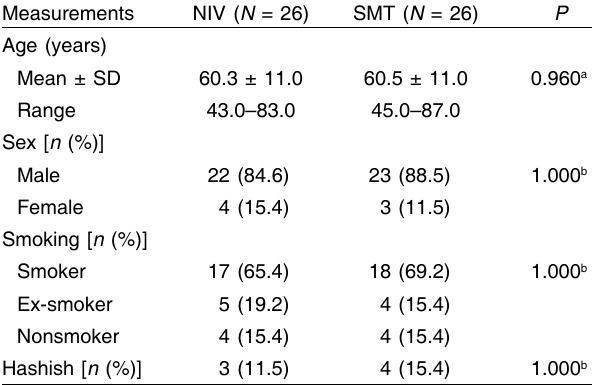
Table 1 Comparison between the study groups as regards age, sex, and special habits